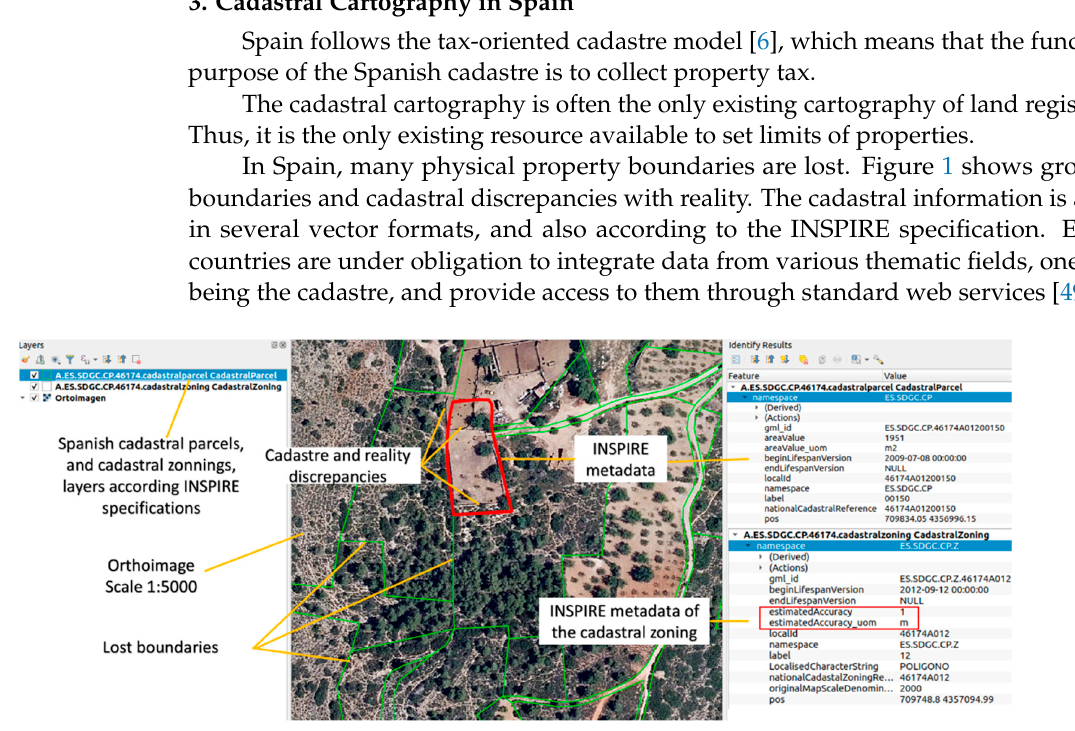
Figure 1. Example of Spanish INSPIRE Cadastral Parcel and Cadastral Zoning layers (themes) information. In the figure, one can see ground lost boundaries and cadastre and reality discrepancies. Source: own elaboration.